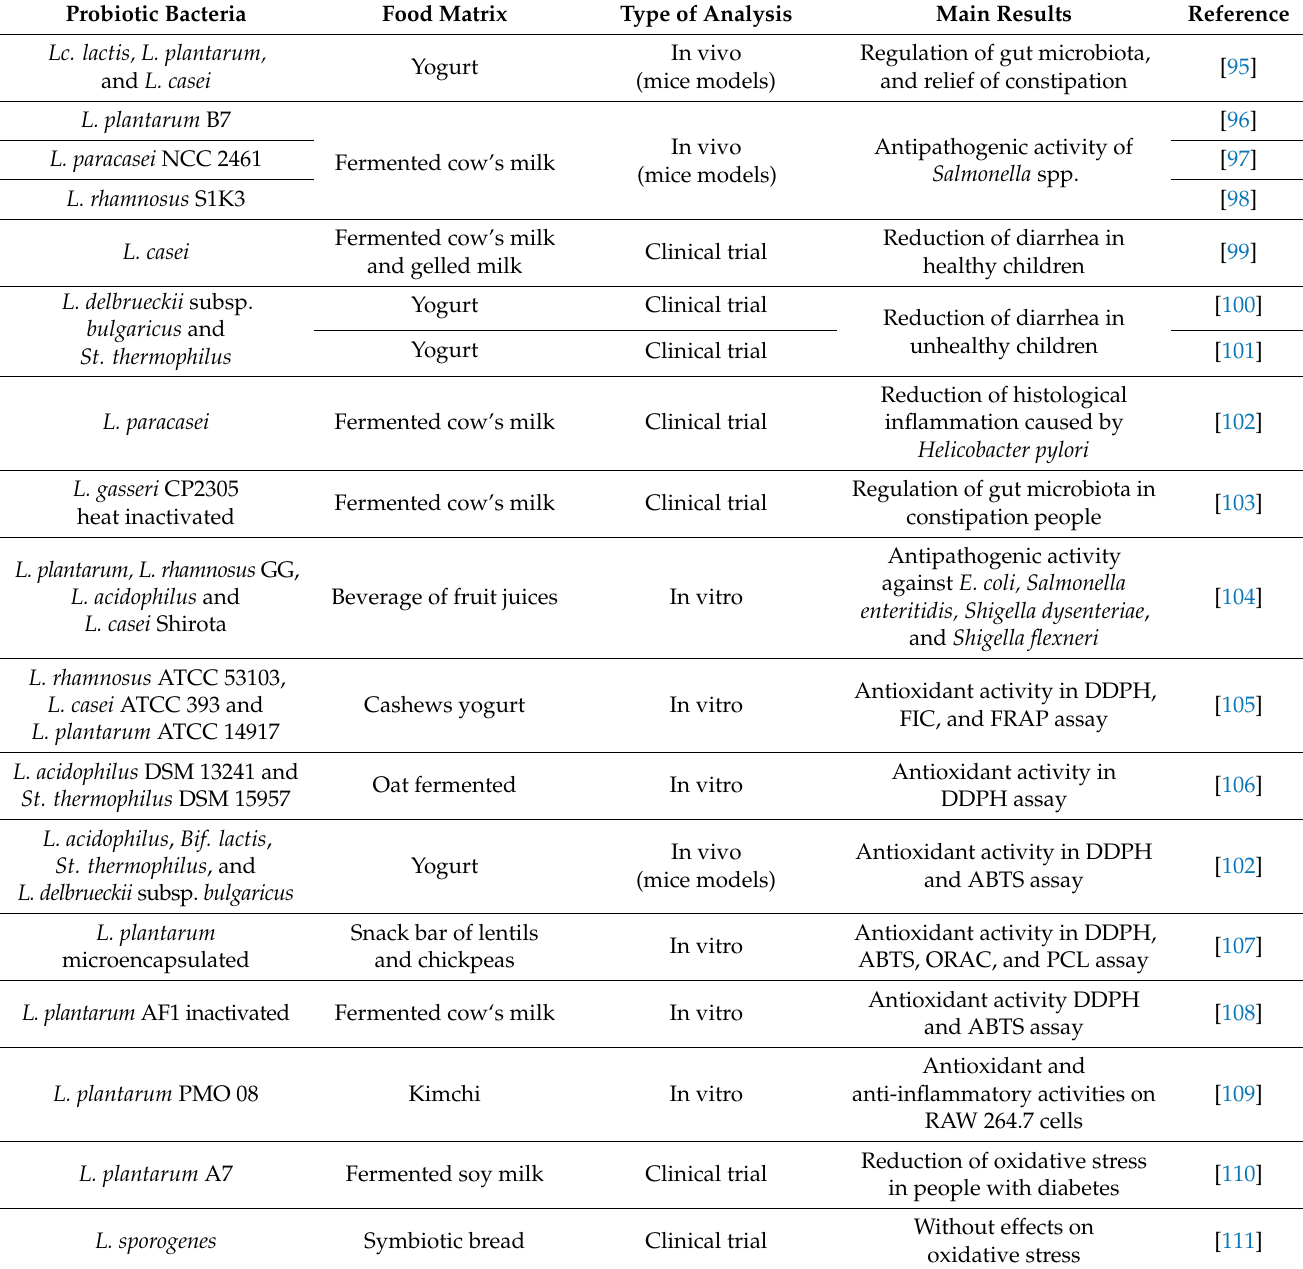
Table 1. Selected studies on the health benefits of consuming food with probiotic bacteria and